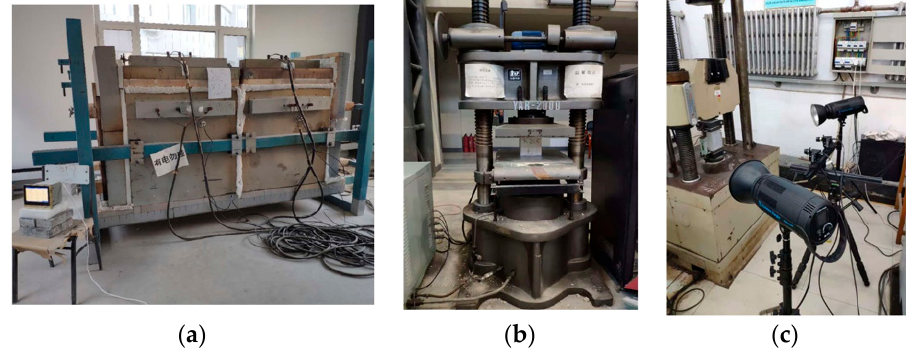
Figure 2. Testing machine: ( a ) Resistance furnace, ( b ) Hydraulic pressure testing machine, ( c ) DIC.